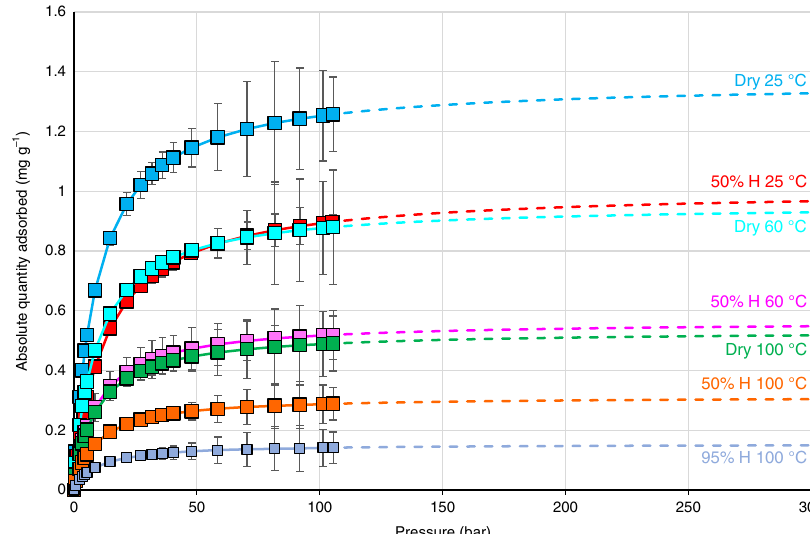
Fig. 6 High-pressure methane adsorption isotherms fi tted to the dual site Langmuir model (dashed line) for 50% RH, 100% RH and dry samples at 25, 60 and 100 °C for matured Grange Hill shale samples from step 5 of the sequential HPWP experiments. The data points are the mean from duplicate experiments and the error bars represent the difference between each pair of values obtained